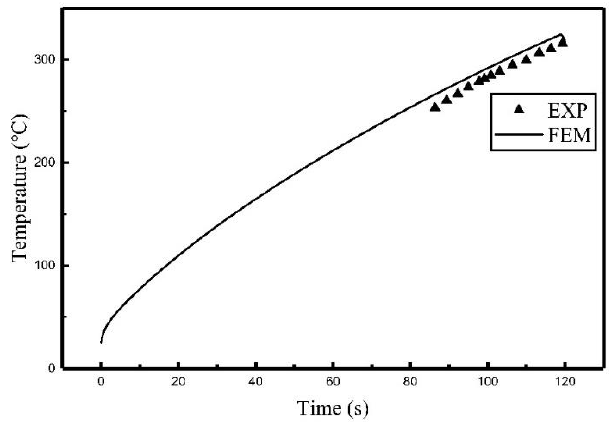
Figure 9. Comparison of the temperature histories of C 3 .